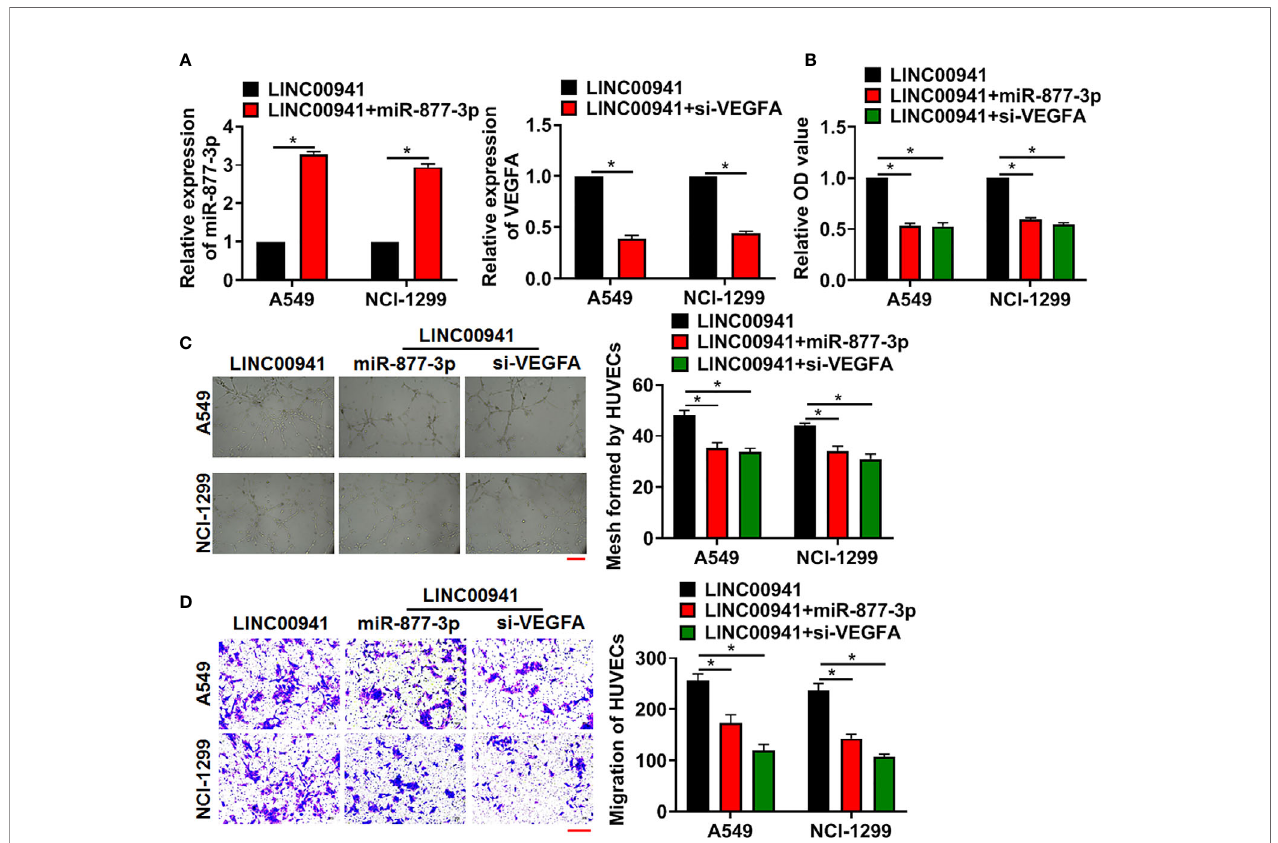
FIGURE 5 | LINC00941 promoted angiogenesis through miR-877-3p/VEGFA axis. A549 and NCI-1299 cells (stably expressed LINC00941) were transfected with miR-877-3p or si-VEGFA. (A) The transfection ef fi ciency of miR-877-3p or si-VEGFA was detected using qRT-PCR. HUVECs were cultured with supernatant of A549 and NCI-1299 after transfection. (B) MTT assay used to detect proliferation of HUVECs. (C) Tube formation assay was to test angiogenesis in HUVECs. Scale bar, 100 m m. (D) Transwell assay was to examine invasion of HUVECs. Scale bar, 100 m m. Data are mean ± SD; *P < 0.05. All experiments were repeated three